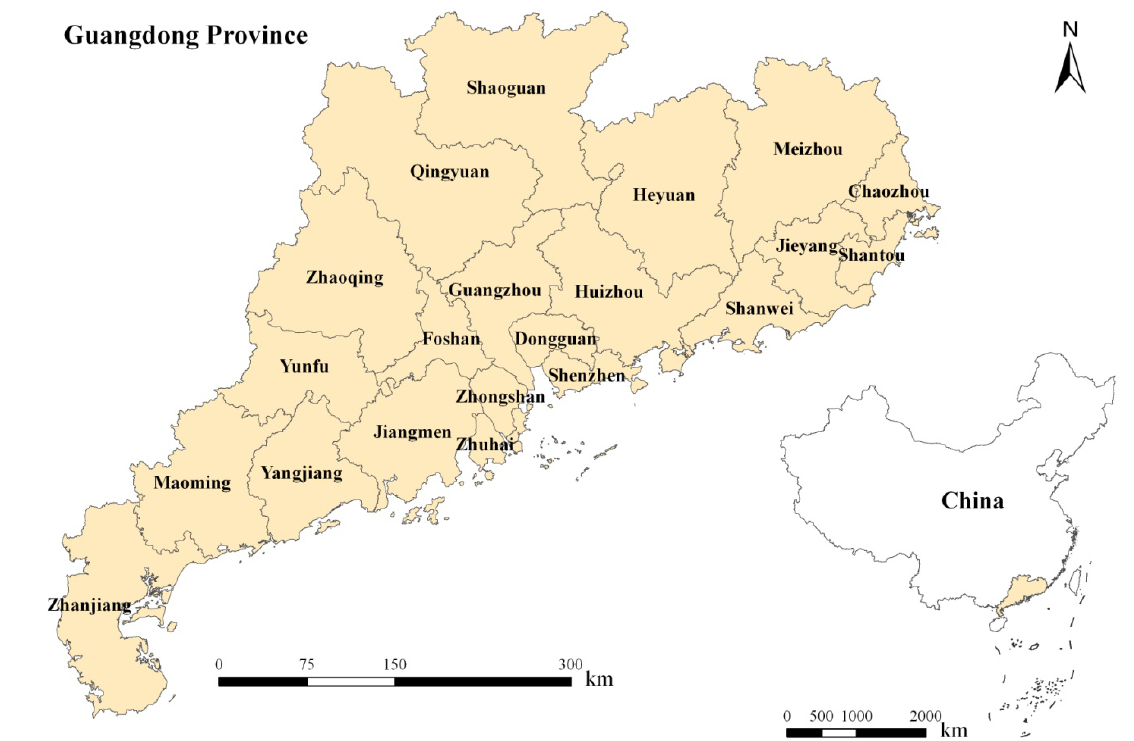
Figure 1. Map showing the geographic location of the study